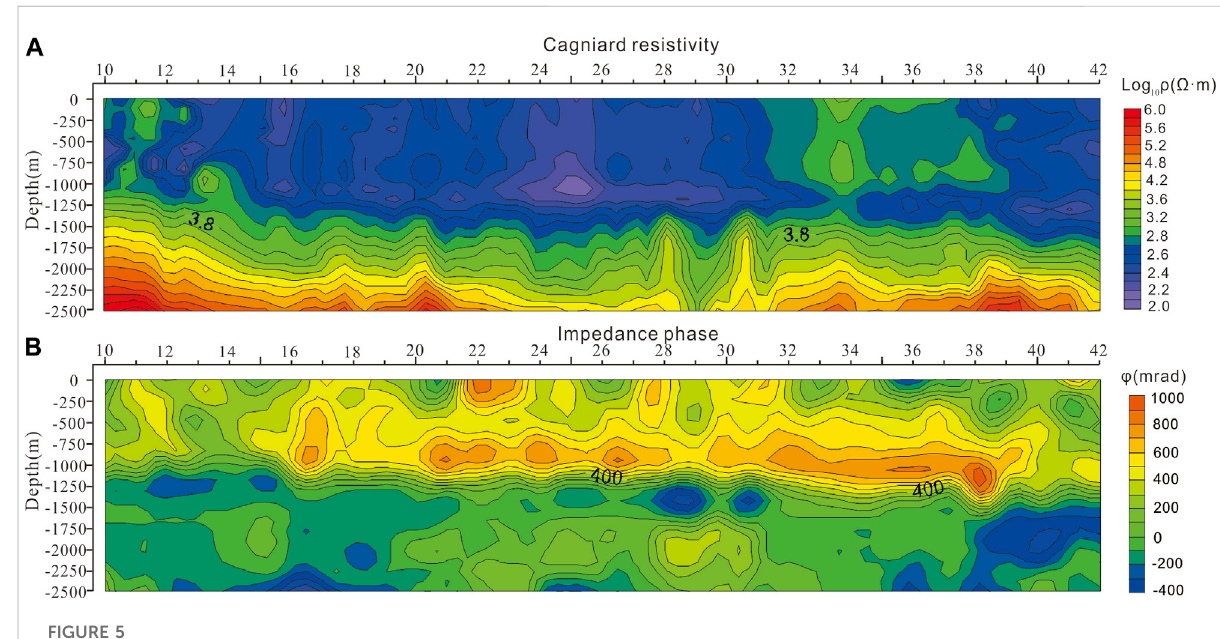
FIGURE 5 Thepseudosection oftheCSAMTpro fi le; (A) Cagniardresistivity; (B) Impedance phase.The X-axisshowsthesurveypoint andtheY-axisshows the apparent